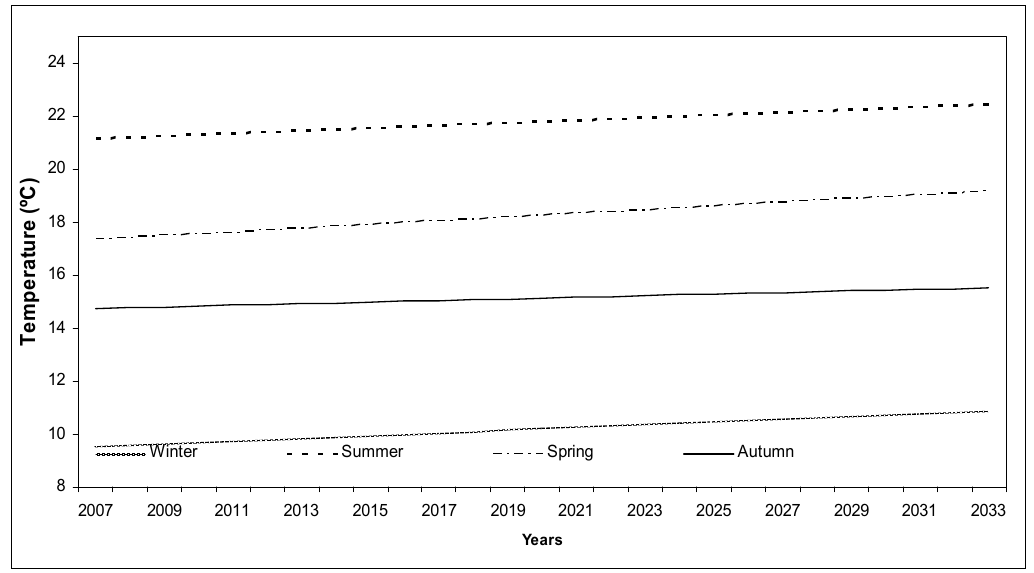
Figure 6. Predicted seasonal temperature increment in the northwest of Spain (°C).